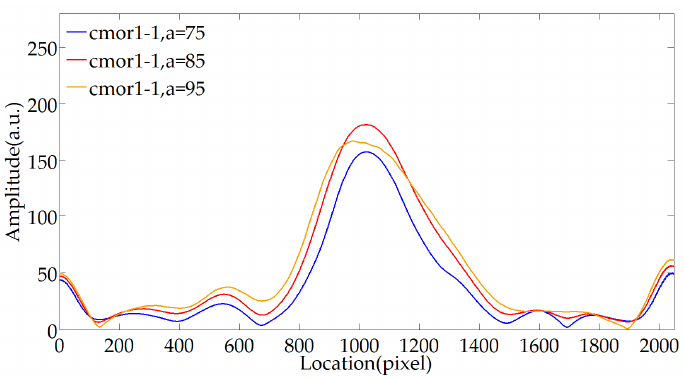
Figure 8. Impact of bandwidth parameter on envelope extraction.